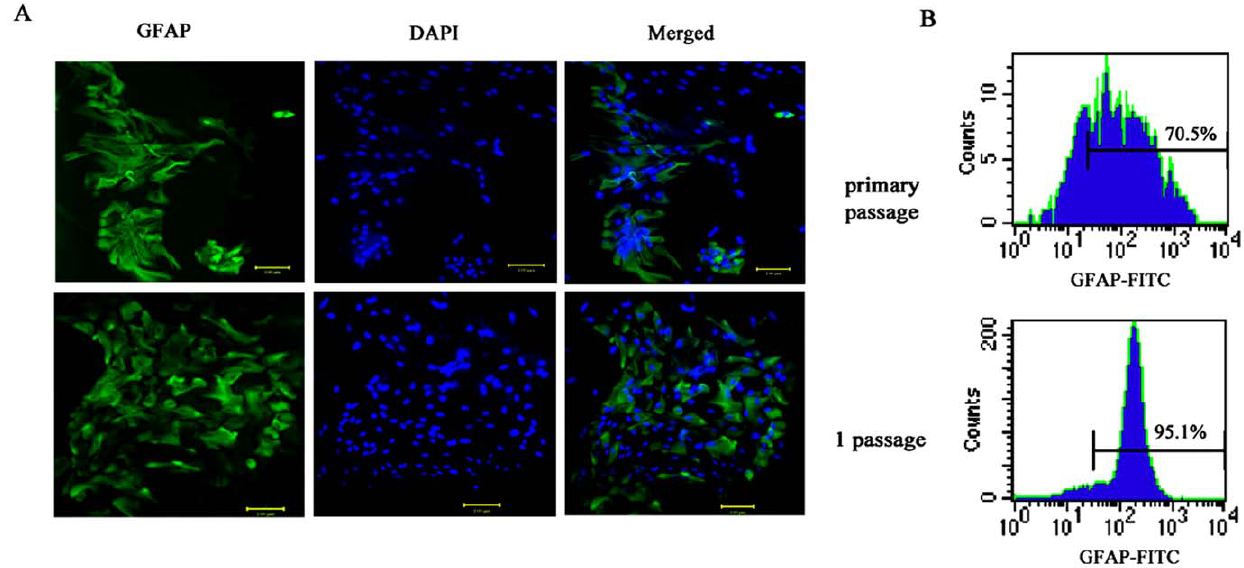
Figure 1. Identification of astrocytes in different passage. Astrocytes in different passage were tested for expression of GFAP (the marker of astrocytes) by immuno-fluorescence staining (A) and flow cytometry (B). The isolated cells display typical astrocyte morphology, bearing satellite processes, and about 70% of the cells initially express GFAP. After subculture, more than 95% percent of derived cells expressed GFAP. Scale bar, 100